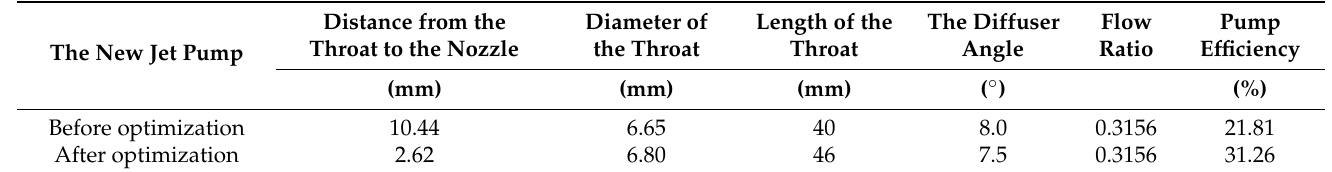
Table 14. Comparative analysis of the structure size and pump efficiency of the new jet pump before and after optimization.